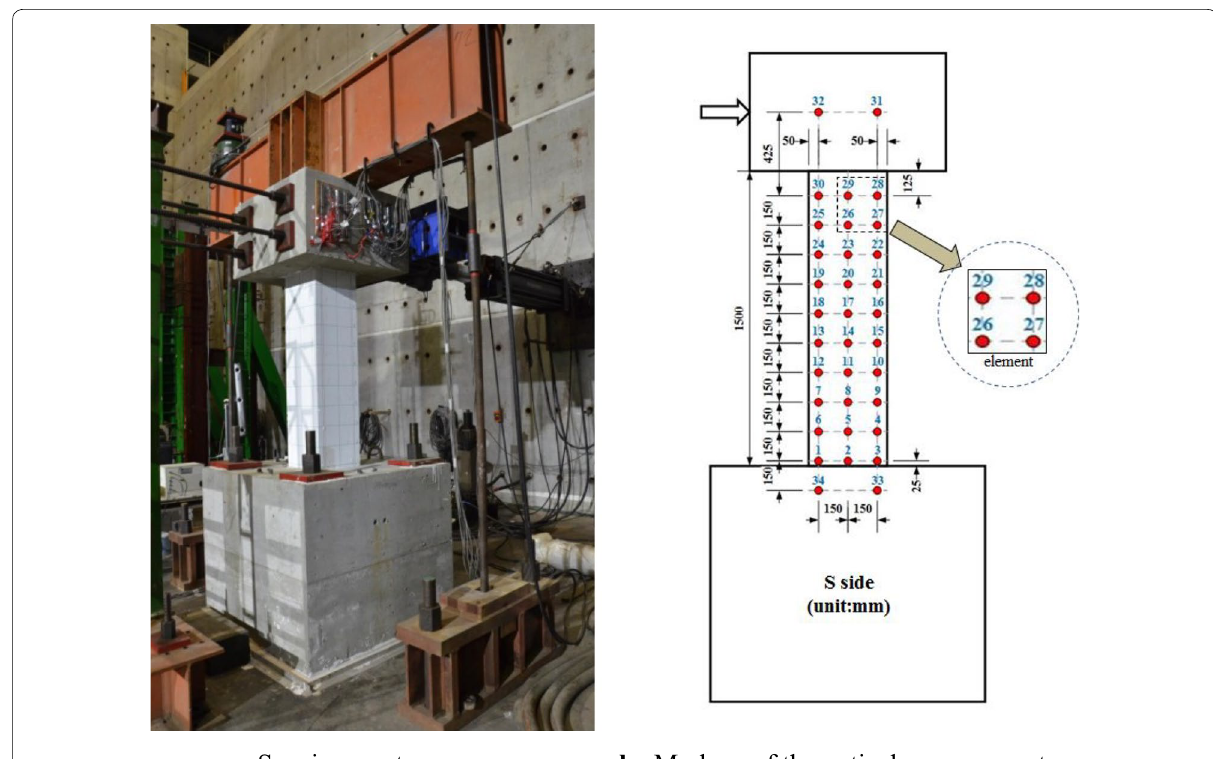
Fig. 5 Column specimens with the single curvature.